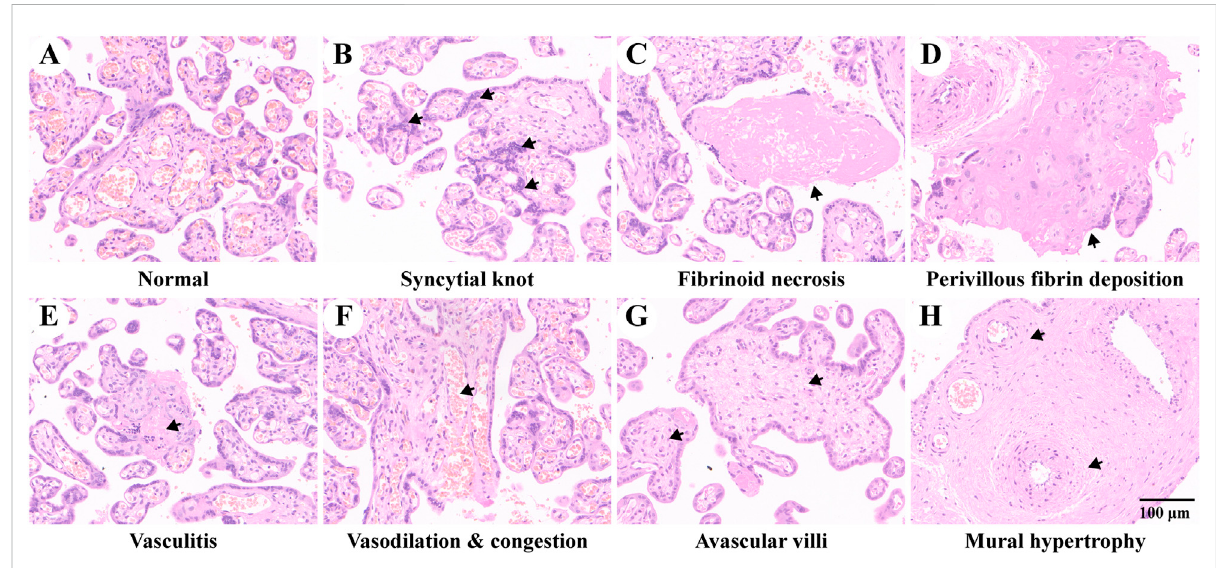
FIGURE 1 Placenta pathology of study subjects. (A) Placenta of normal pregnancy. B – H show placental pathological changes of pre-eclampsia. (B) Increased syncytial knots composed of aggregated syncytiotrophoblast between different villi. (C) Fibrinoid necrosis with hyalinization in the decidua. (D) Increasedperivillous fi brindeposition. (E) Intravillouslymphohistiocyticin fi ltrationofvasculitis. (F) Vascularvasodilationandcongestion. (G) Avascular villi due to ischemia. (H) Mural hypertrophy as speci fi c features of decidual arteriopathy. The representative pathological changes are indicated with black